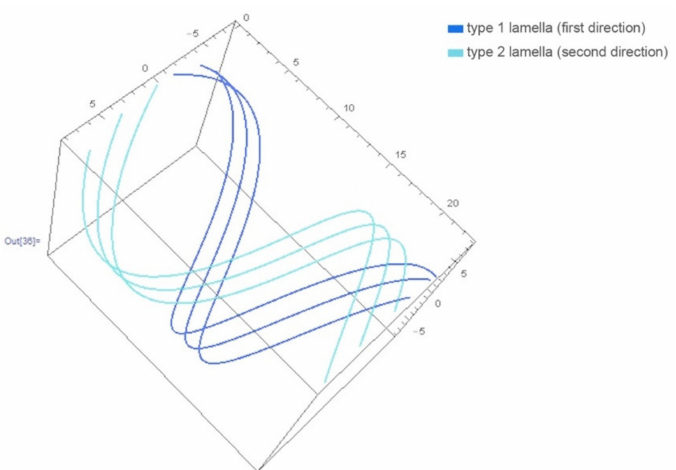
Figure 9. The graphic presentation of the parametric equations for the helixes developed in Wolfram Mathematica. The blue graph shows the helix from one direction and the green one shows the helix from the other, translated for half of the lamella length.